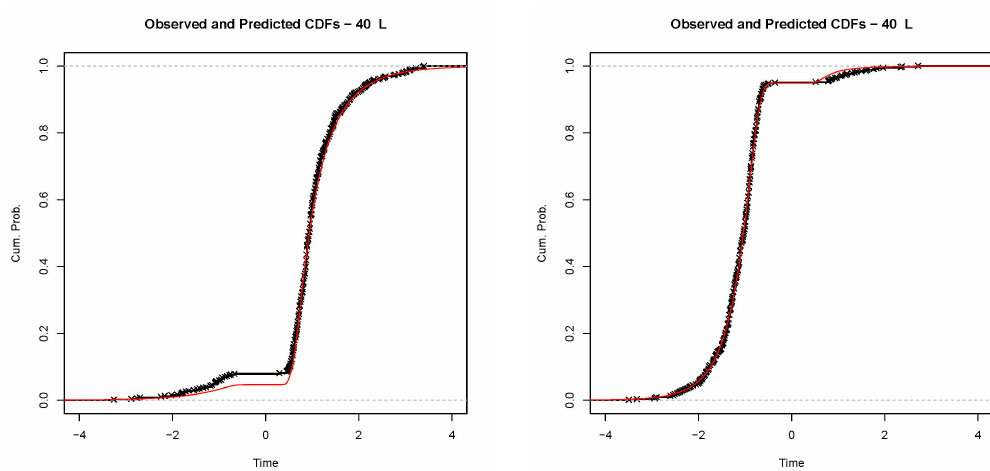
Figure A2. Comparison of the empirical and the predicted cumulative density function (CDF) for words ( left ) and nonwords ( right ). Note that the red line represents the predicted CDF and the crossed line represents the observed CDF.